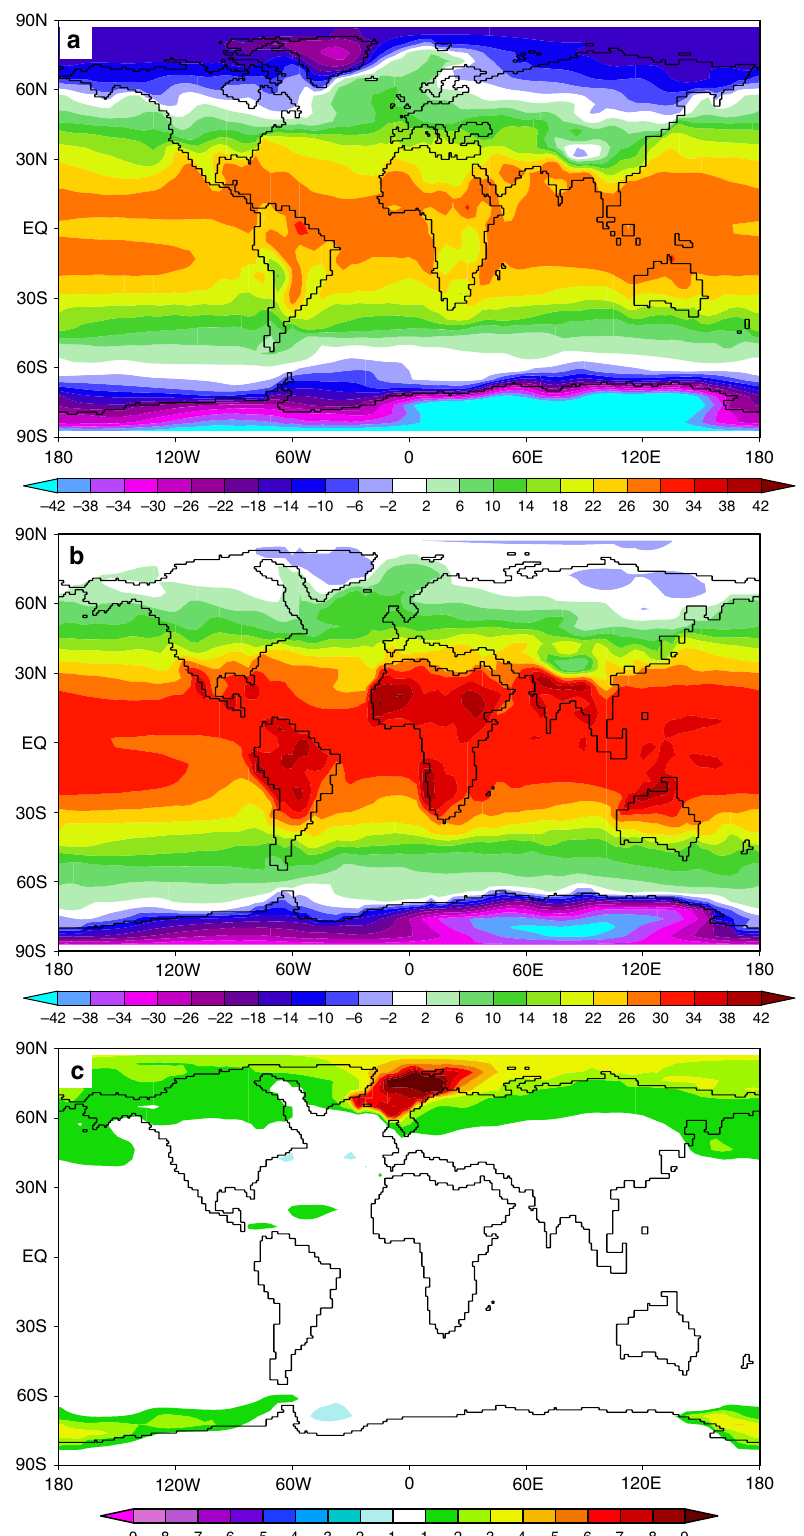
Figure 2 | Modelled climatologies of surface air temperatures. Surface air temperatures (SAT in (cid:2) C) for ( a ) the preindustrial, ( b ) the time interval spanning 35–16Ma and ( c ) the SAT response to the opening of the Greenland–Scotland Ridge